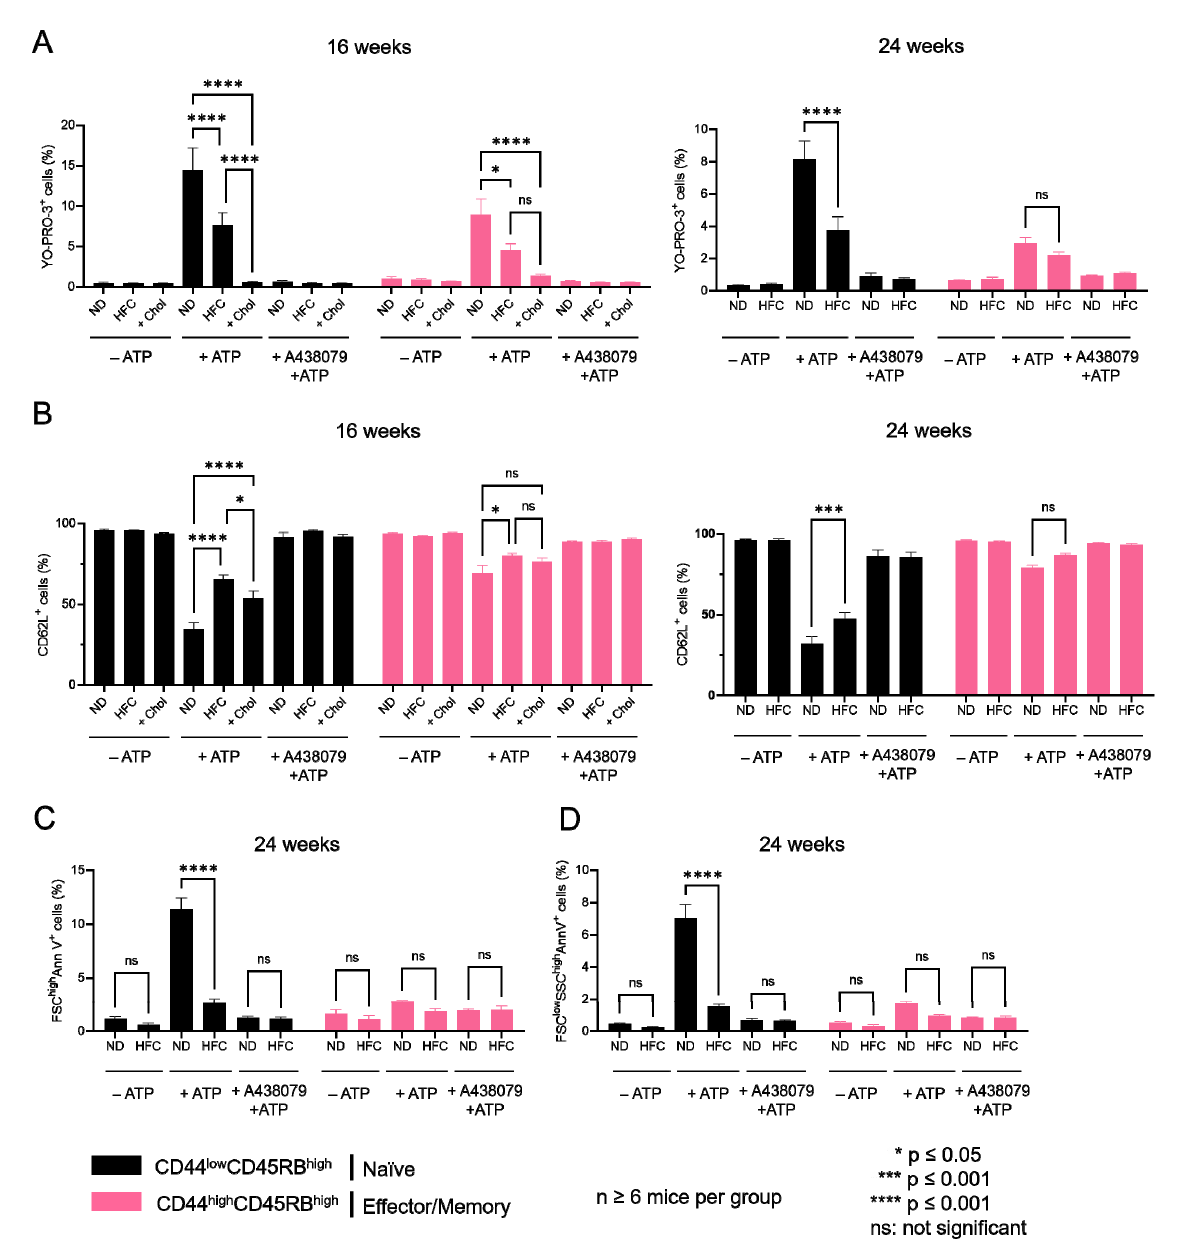
Figure 6. Diet-induced hypercholesterolemia affects P2X7-induced cellular responses in naive and effector/memory CD8 + T cells. Following stimulation with 500 µ M eATP for 30 min at 37 ◦ C with or without pre-treatment with 10 µ M of the P2X7 antagonist A438079 (+A438079), P2X7-dependent pore formation ( A ), CD62L shedding ( B ), reversible PS externalization in liv- ing cells (FSC high AnnV + ) ( C ), and cell death characterized by irreversible PS externalisation (FSC low SSC high AnnV + ) ( D ) were evaluated in CD44 low CD45RB high naive and CD44 high CD45RB high effector/memory CD8 + T cells from mice fed either a normal diet (ND) or a high-fat diet (HFC) maintained for 16 (left panel) or 24 weeks (right panel). Splenocytes from mice fed a normal diet were treated with MBCD/Chol complexes (+Chol) ex vivo as a positive control for cholesterol enrichment. Data are expressed as the mean of percentages ( ± SEM, n ≥ 6 mice). Asterisks denote statistically significant differences * p ≤ 0.05, *** p ≤ 0.001, **** p ≤ 0.0001, ns: not